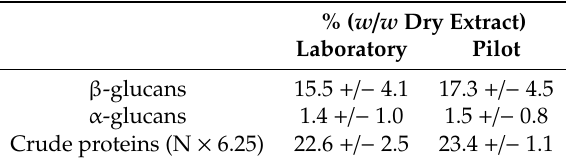
Table 2. Glucan and crude protein contents of Pleuran CCWE obtained with laboratory and pilot processes. Data are means +/ - standard deviation ( n = 23 for laboratory process; n = 12 for pilot process).